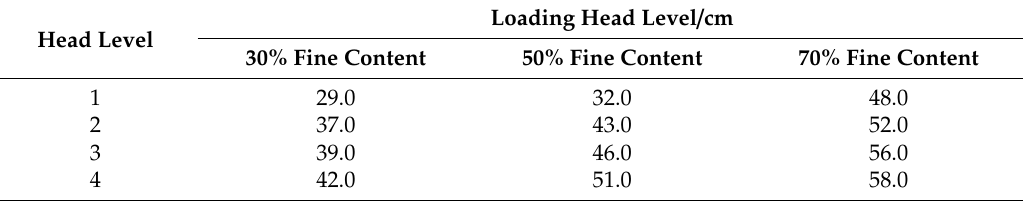
Table 2. Head loading values at various levels.